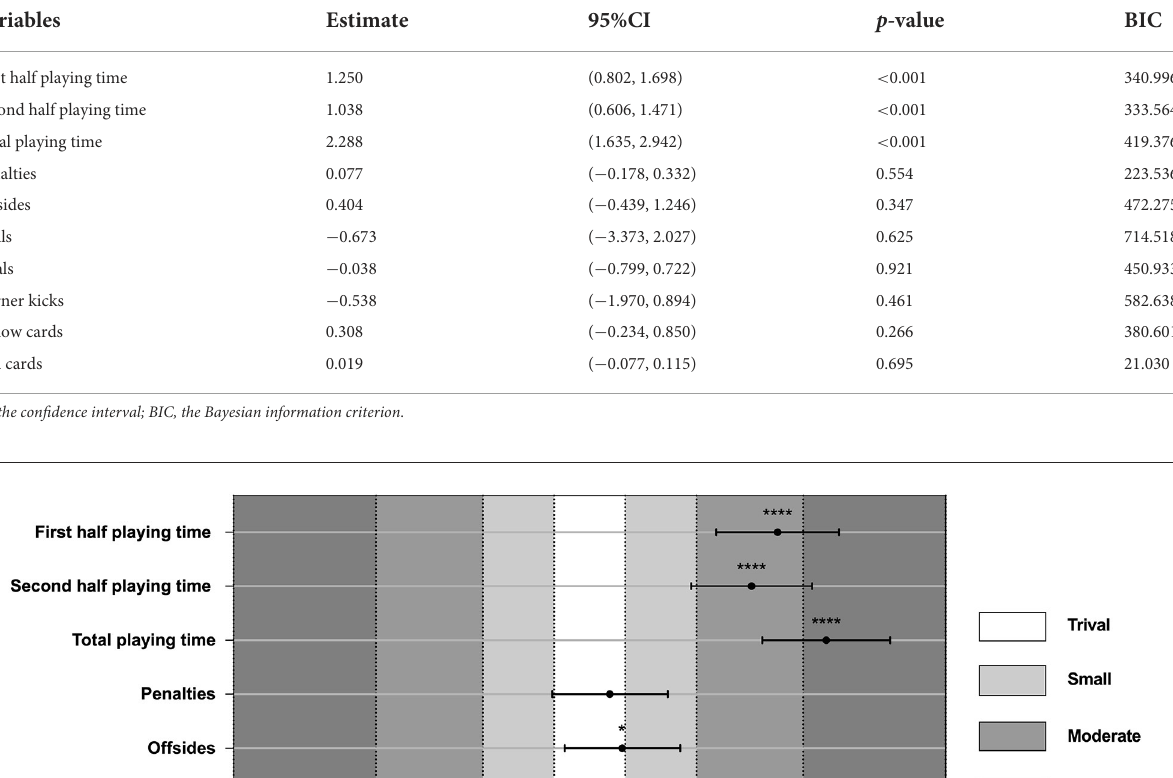
TABLE 2 Results of the generalized linear model for each match variable.